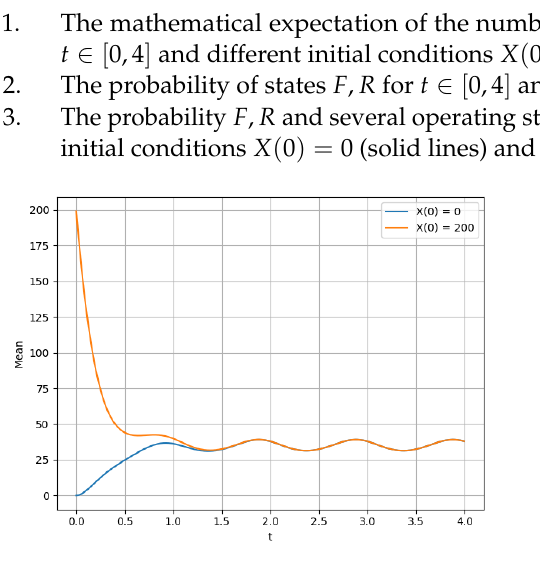
Figure 2. Average E ( t , k ) for t ∈ [ 0,4 ] at N =